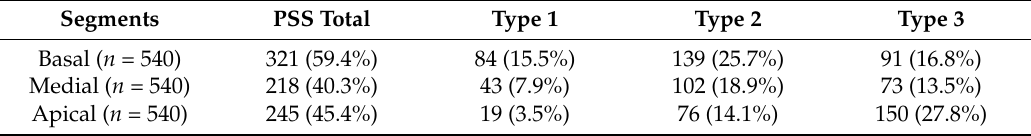
Table 2. PSS and its types according to regions of the left ventricle (LV) (90 patients). Table 3. PSS and its types according to segments of the LV (90 patients).